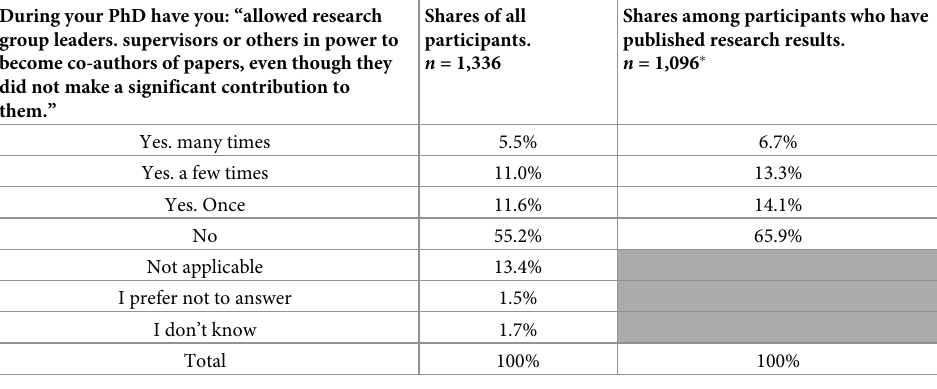
additional 18 participants who could not be classified into one of the five main faculties.